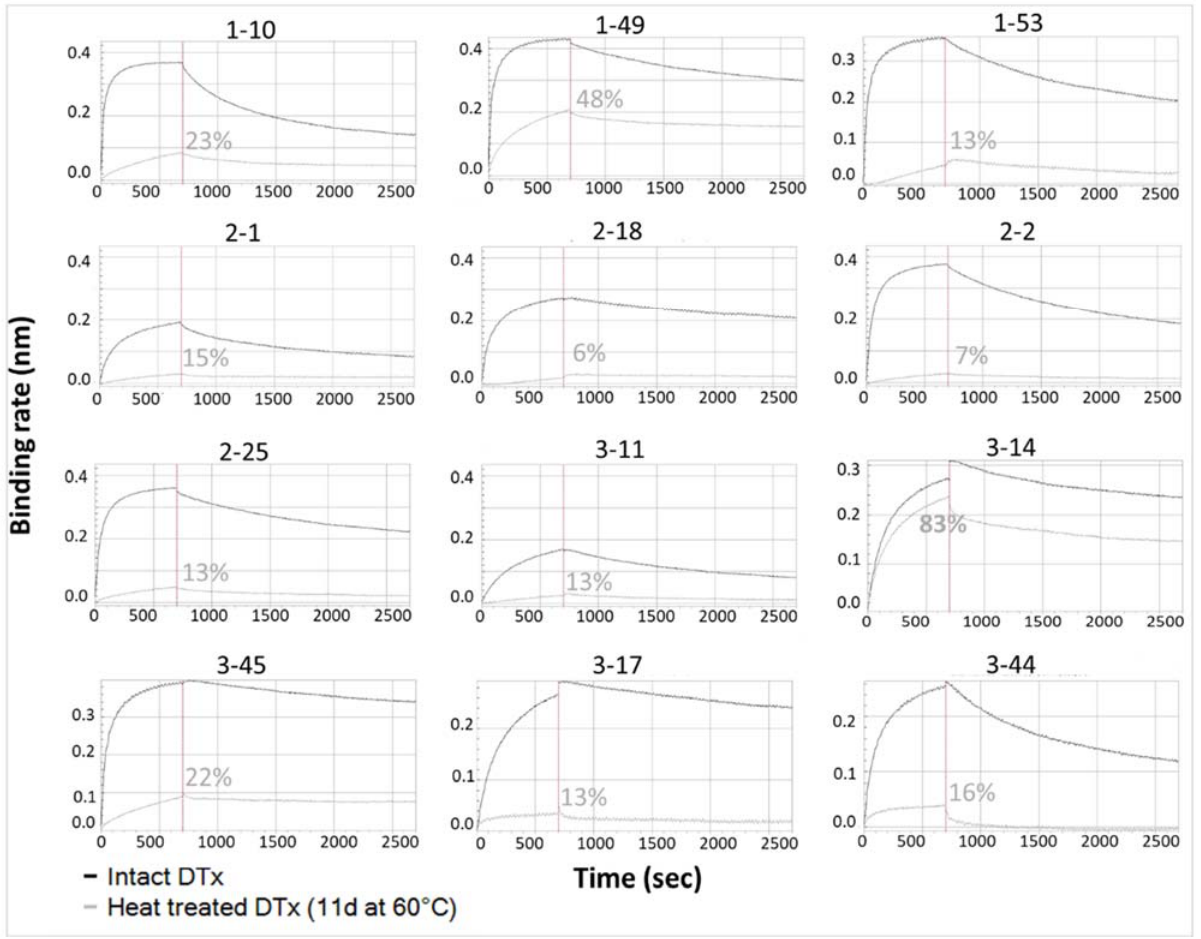
Figure 2. Binding curves of 12 individual mAbs to intact or degraded DTxd. Binding of each of 12 mAbs to untreated DTxd (black) or heat treated DTxd (11 d, 60 °C) (grey) is depicted. Association and dissociation were recorded in real time in nm. The binding rate is the height of the curve (nm) at the end of the association step (vertical line, 700 s). Binding rate of mAb to heat treated DTxd/untreated DTxd is shown (%). Table 3. Summary of the SEAT performance assessment.